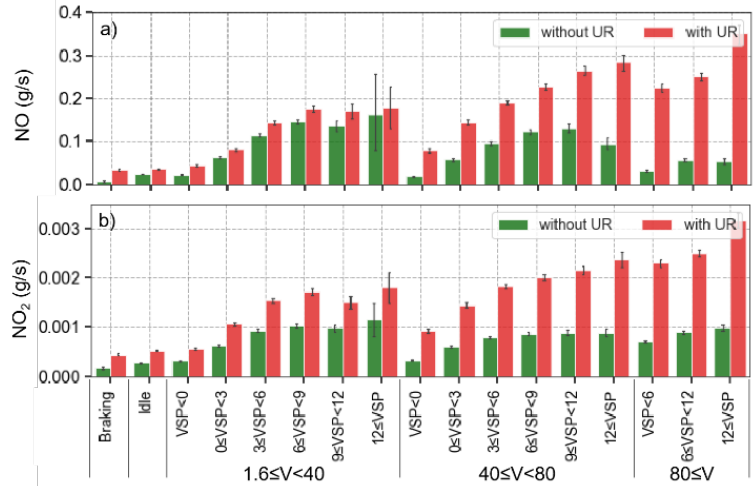
Figure 2. Comparison of average VSP-bin NO ( a ) and NO 2 ( b ) mass emission rates between the situation with and without the illegal application of urea regulator.